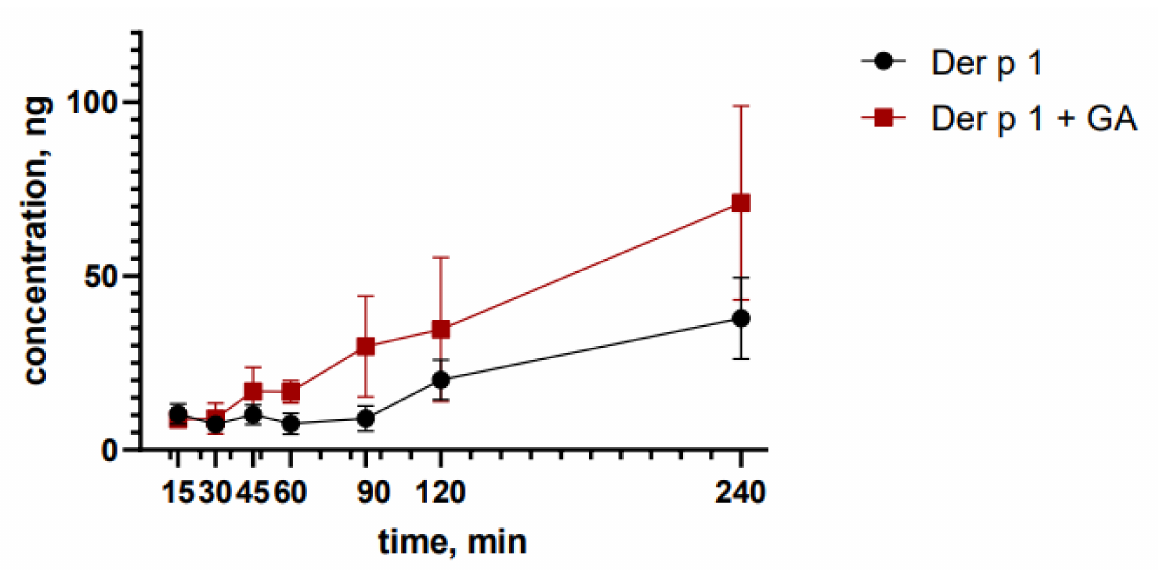
Figure 3. Evaluation of the permeability of Der p 1 across the RPMI-2650 monolayer. The GA–Der p 1 mixture significantly increased the relative number of CD4 + cells in comparison to the control in the culture of PBMCs from healthy donors (Figure 4). Adding only GA did not lead to a statistically significant increase in the percentage of CD4 + cells; however, there was a tendency ( p = 0.09) to increase the number of CD4 + cells. A similar result may indicate an enhancement of the cellular immune response, since GA is known to direct the immune response towards Th1 [5].